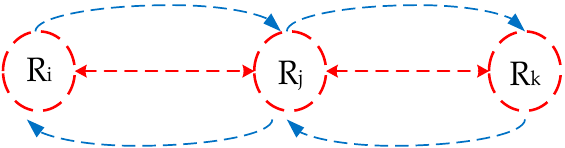
Figure 8. TTRP protocol evaluation trustworthiness diagram of relay node R j .